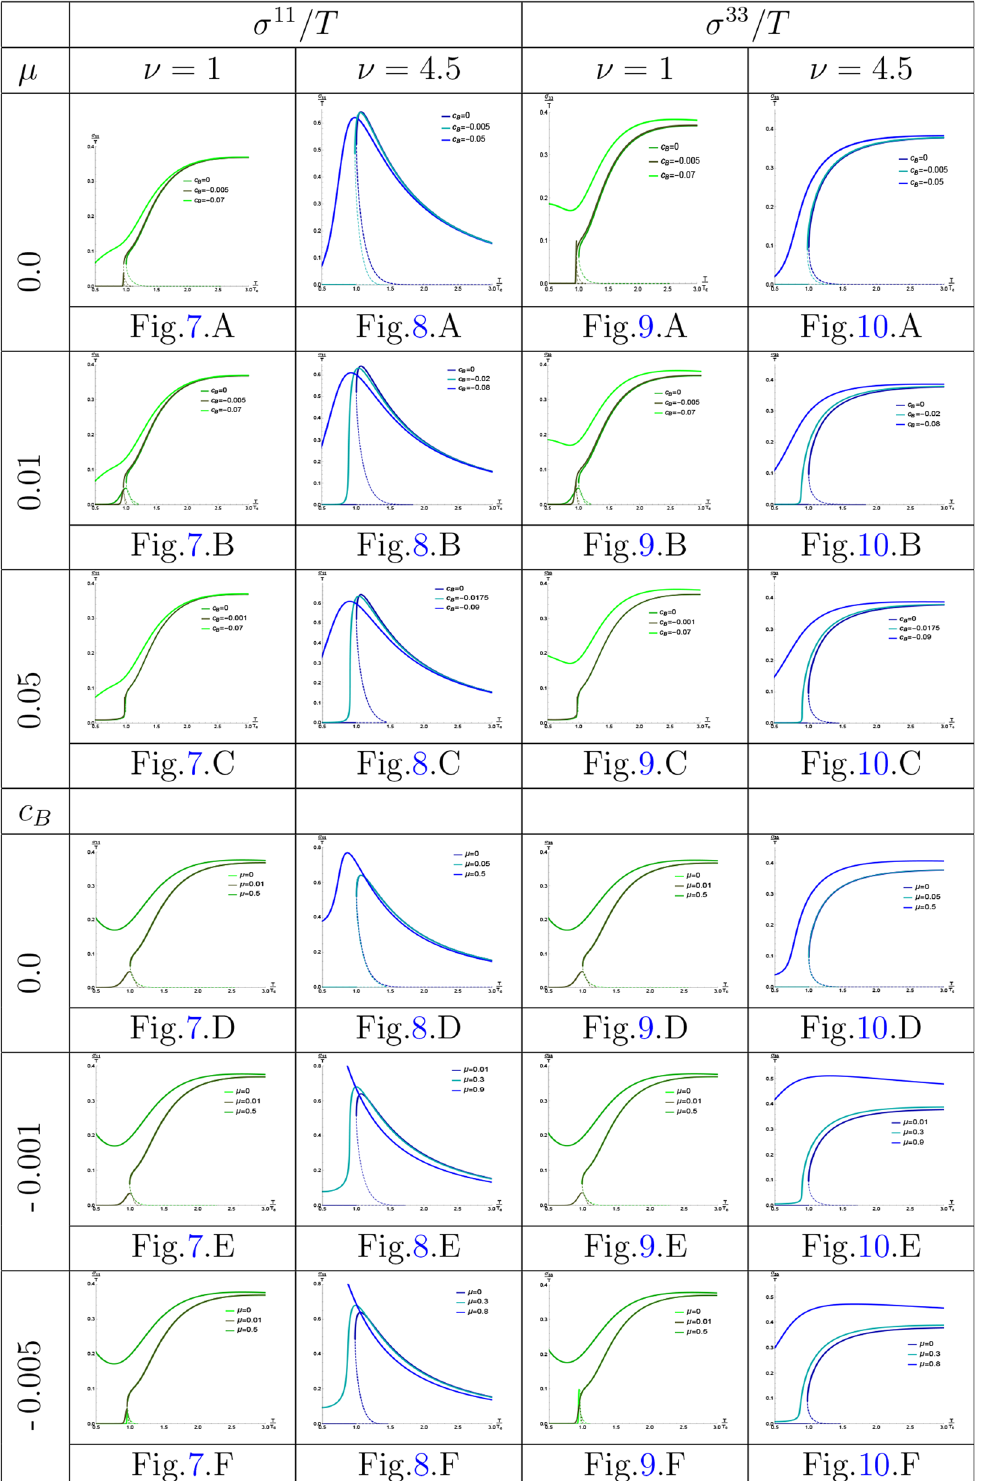
Table 2 Table shows dependencies of the ration of the DC conductivity to temperature on anisotropy, chemical potential and magnetic field. Here f 0 is given by